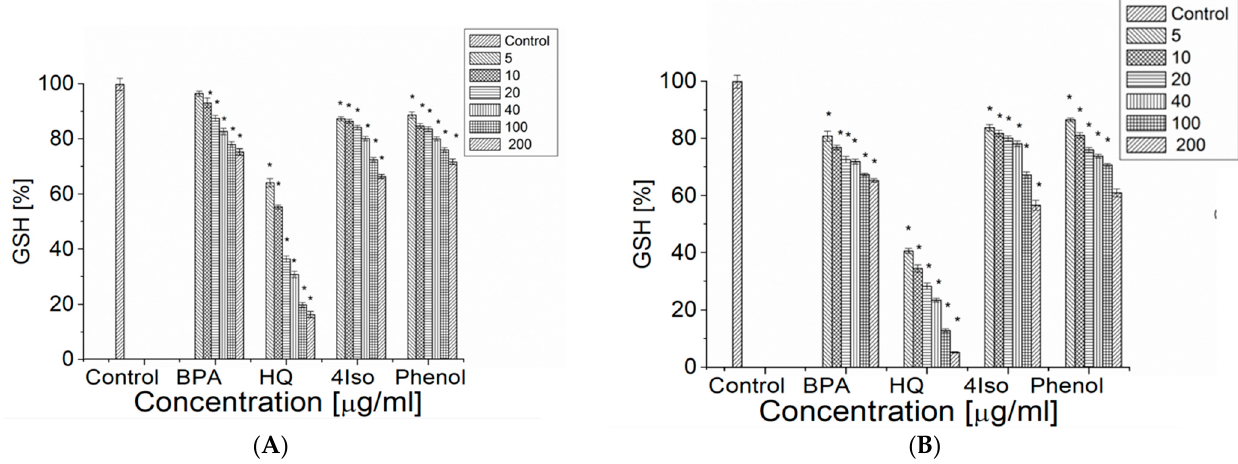
Figure 4. The level of reduced glutathione (GSH) in the control erythrocytes and the ones incubated with BPA, hydroquinone, phenol and 4-isopropylphenol in the concentration range 5–200 μ g/mL after 4 h ( A ) and 24 h ( B ) of incubation. The data are presented as the means ± SE. * the effects of compounds were statistically significant.